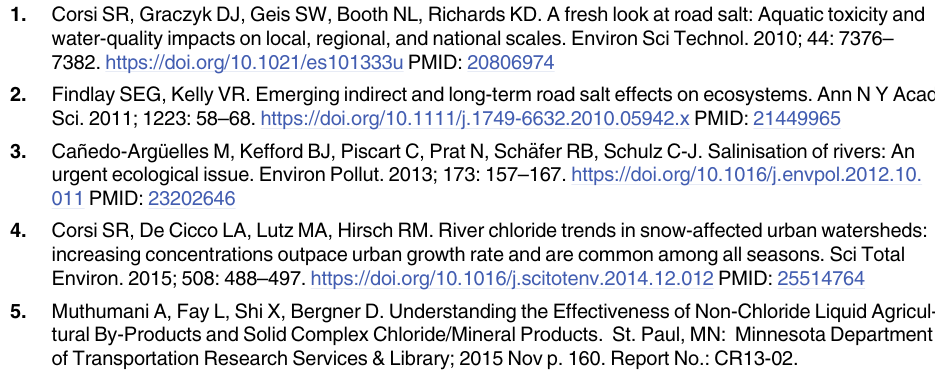
S4 Fig. Comparison of chemical oxygen demand (COD) concentrations in grab and (clos- est) flow-composite samples at the three sites downstream from the airport. Dashed gray line, 1:1 relation; solid black line, regression (in log10; R 2 = 0.86) across all sites and samples. Dark brown points and line, data and regression (in log10; R 2 = 0.92) between samples col- lected at DS1; medium brown points and line, data and regression (in log10; R 2 = 0.80) between samples collected at DS2; light brown points and line, data and regression (in log10; R 2 = 0.83) between samples collected at DS3.